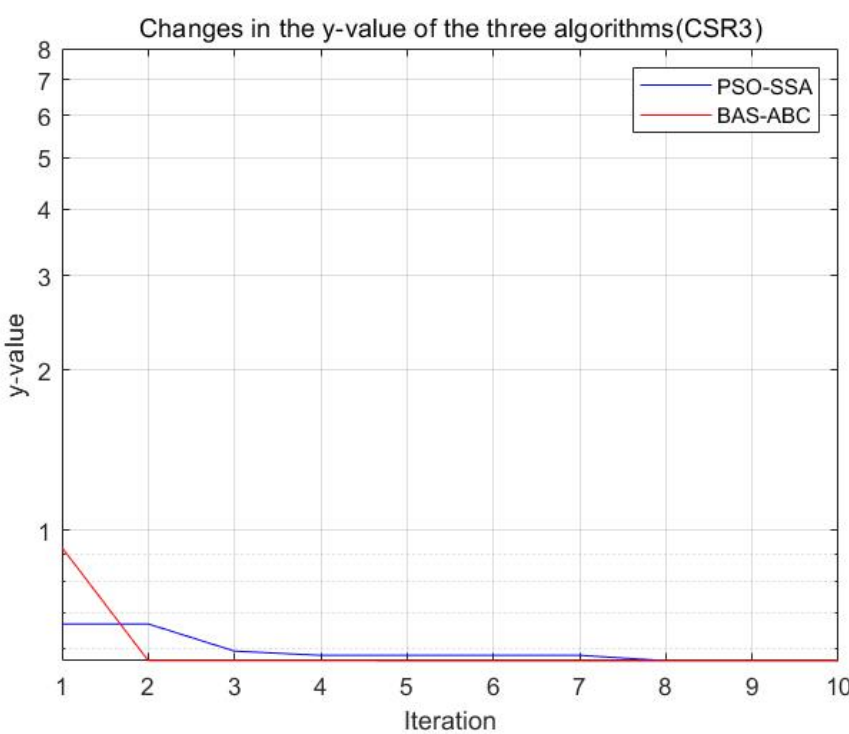
Figure 27. Changes in the 𝑦 value of the two algorithms (CSR3).